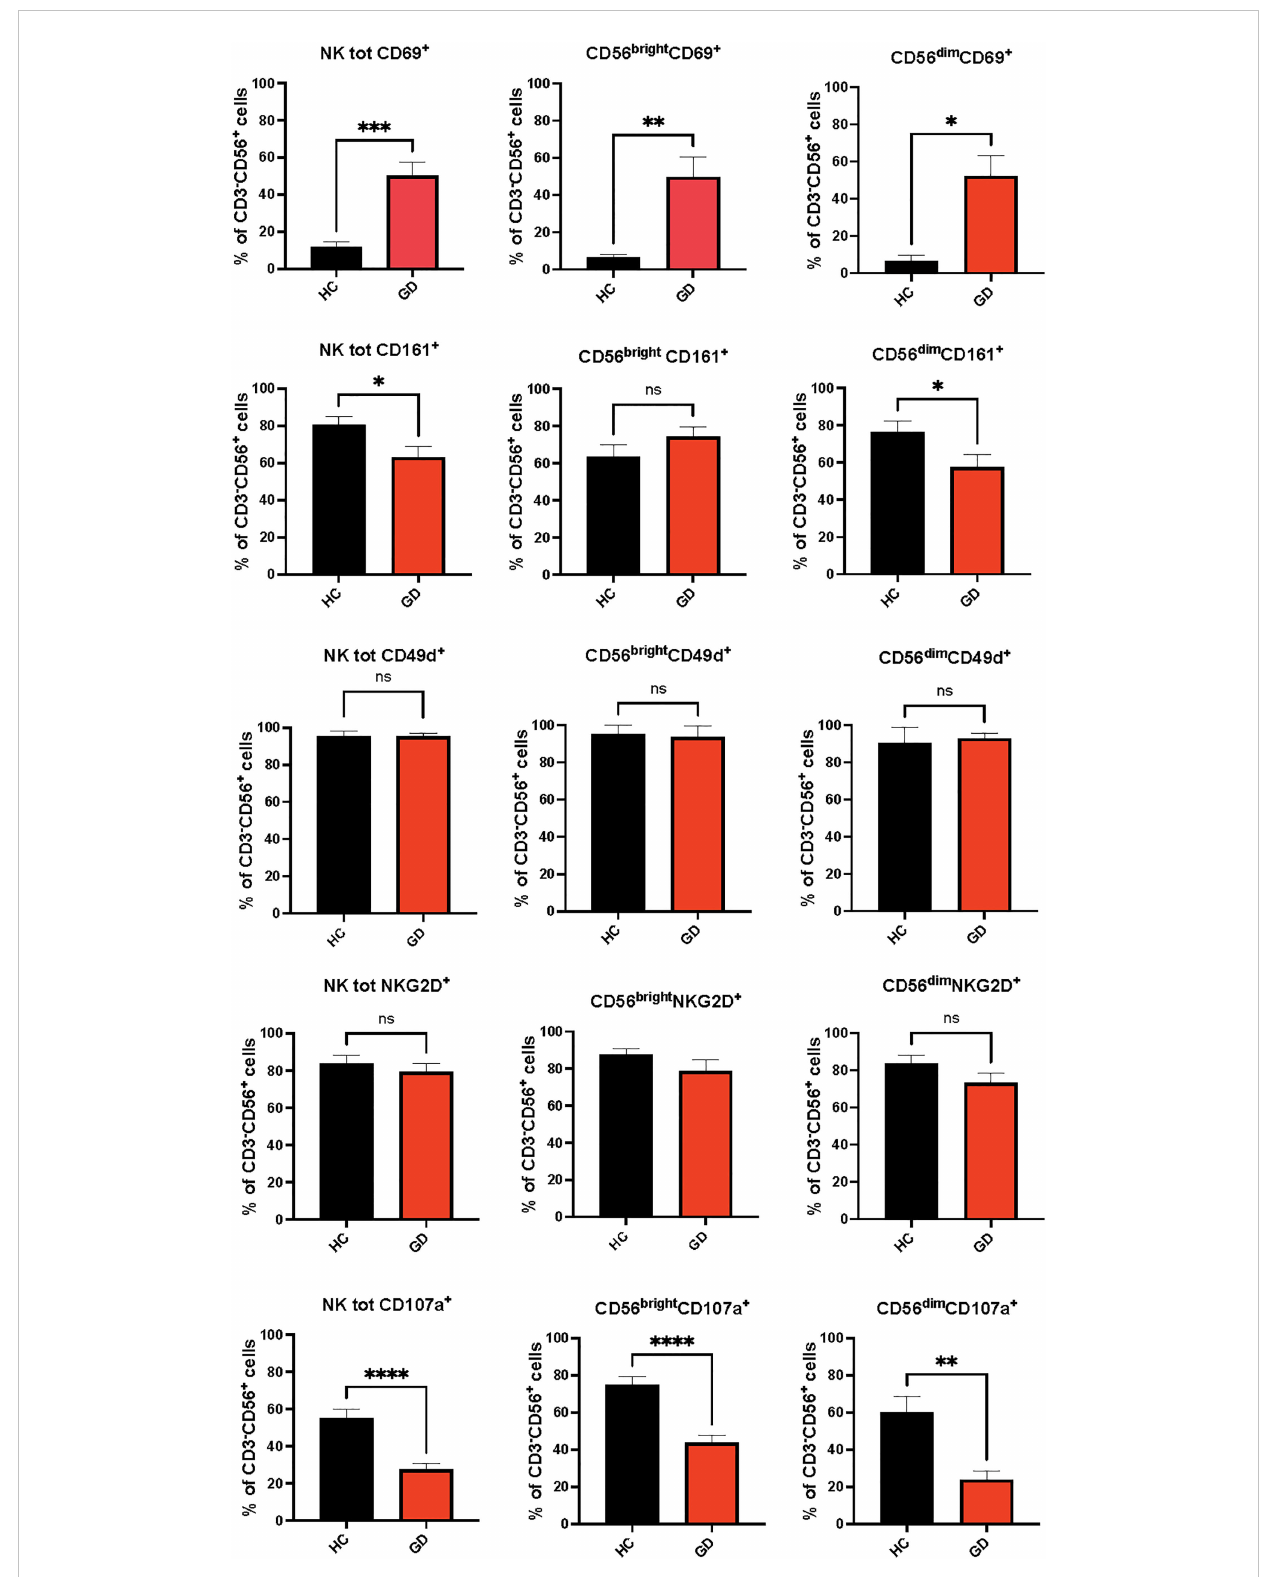
FIGURE 2 Phenotypic (CD69, CD161, NKG2D, CD49d) and functional (CD107a) results of natural killer cells from Graves ’ disease patients, at baseline, and healthy controls. Twenty- fi ve age and sex-matched healthy donors served as control group. Histograms showed the percentages of NK cells total NK cells and CD56bright and CD56dim subsets expressing activating (CD69+), inhibitory (CD161 + , NKG2D + ) receptors, the integrin CD49d and having cytotoxic ability (CD107a + ). Data were shown as mean SEM (standard error of the mean), student t-test, *p<0.05, **p<0.01, ***p< 0.001, ****p<0.0001. GD, Graves ’ disease patients; HC, healthy controls; MMI, methimazole. ns, not statistically signi fi